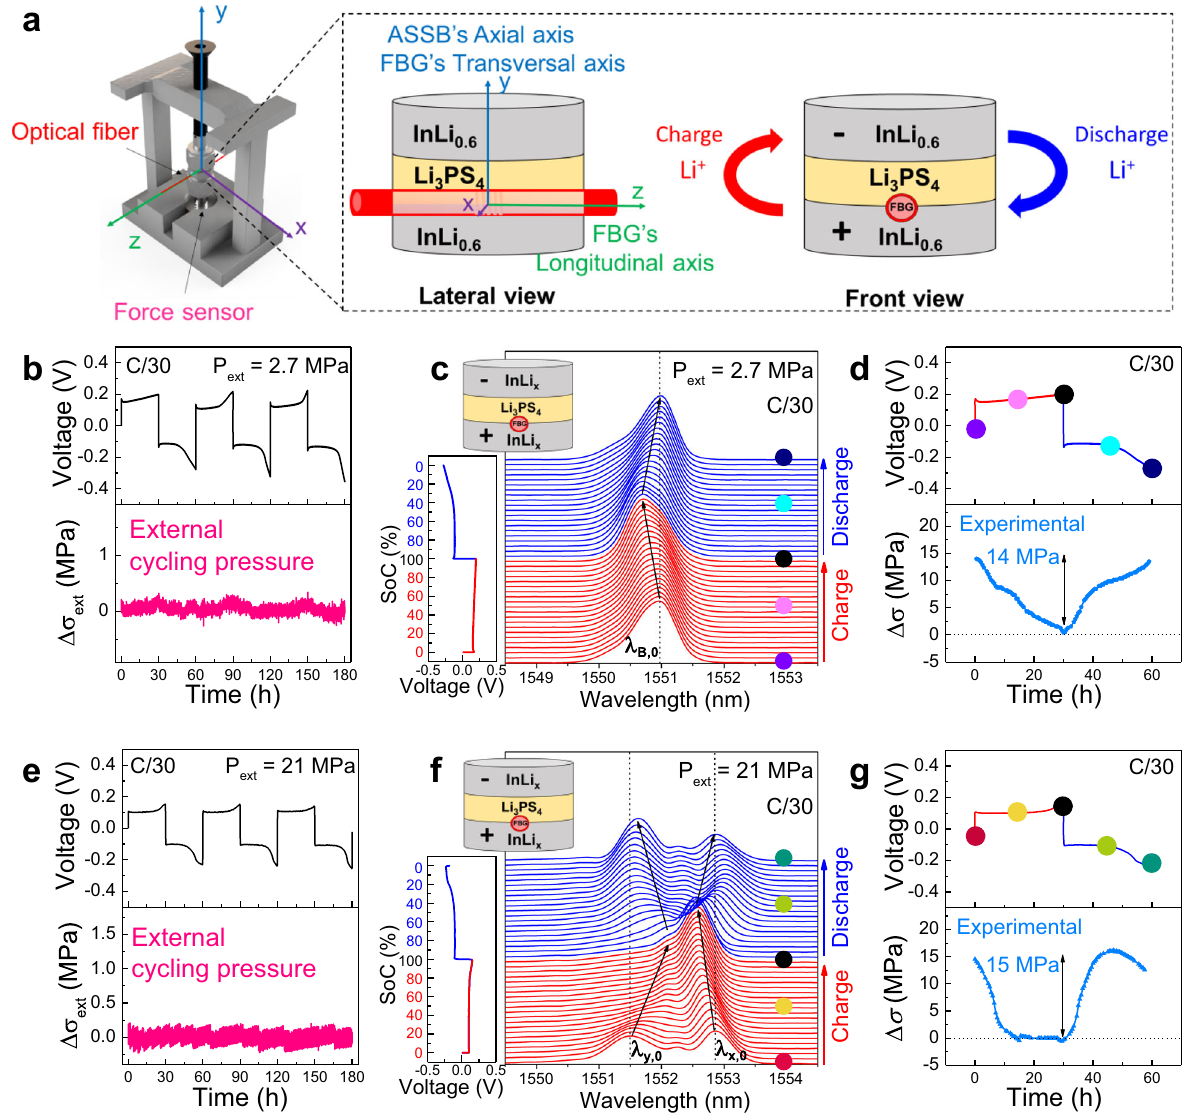
Fig. 6 Operando Li-driven stress monitoring in a symmetrical InLi x | LPS | InLi x cell by an FBG located at the interface between the cathode and the solid-state electrolyte. a Scheme of the modi fi ed Swagelok cell with the implemented optical fi ber and the external force sensor. The corresponding X- , Y- , and Z- axis are detailed in the different views. For the sake of simplicity, the “ longitudinal ” and “ transversal ” axis is used with respect to the optical fi ber, and the “ axial ” axis is only used with respect to the cell. The direction of the Li + ions during charge/discharge is detailed in the scheme. b Time-resolved voltage (top), and external cycling pressure (bottom) for the aforementioned ASSB cycled at C/30 (5.83 mA g − 1 ) and 25 °C for three consecutive cycles, at an externally applied pressure of 2.7 MPa, and e 21 MPa. c , f 2D stack view of the collected spectra by the FBG sensor, with the corresponding galvanostatic charge/discharge cycle when the externally applied pressure is 2.7 and 21 MPa, respectively. The charge and discharge processes are plotted in red and blue, respectively. d Galvanostatic cycle (top), and o perando stress evolution obtained internally by the FBG sensor and with the experimental calibration of the sensor (bottom) when the externally applied pressure is 2.7 MPa, and g 21 MPa. The points at the beginning/middle/end of the charge/ discharge are indicated by colored dots, also marked in the corresponding FBG spectra in ( c ). Note that due to the location of the FBG sensor in the positive electrode, the relative stress is normalized ( Δ σ = 0 MPa) at the beginning of the discharge to compare positive stress